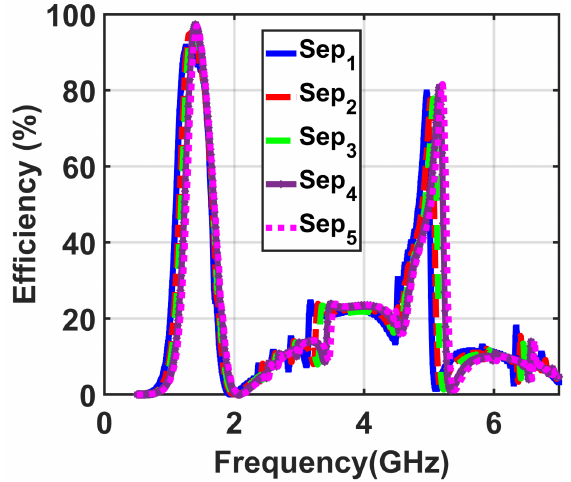
Figure 9. Obtained results demonstrating the efficiency with the separation between adjacent cells of the implemented supercell